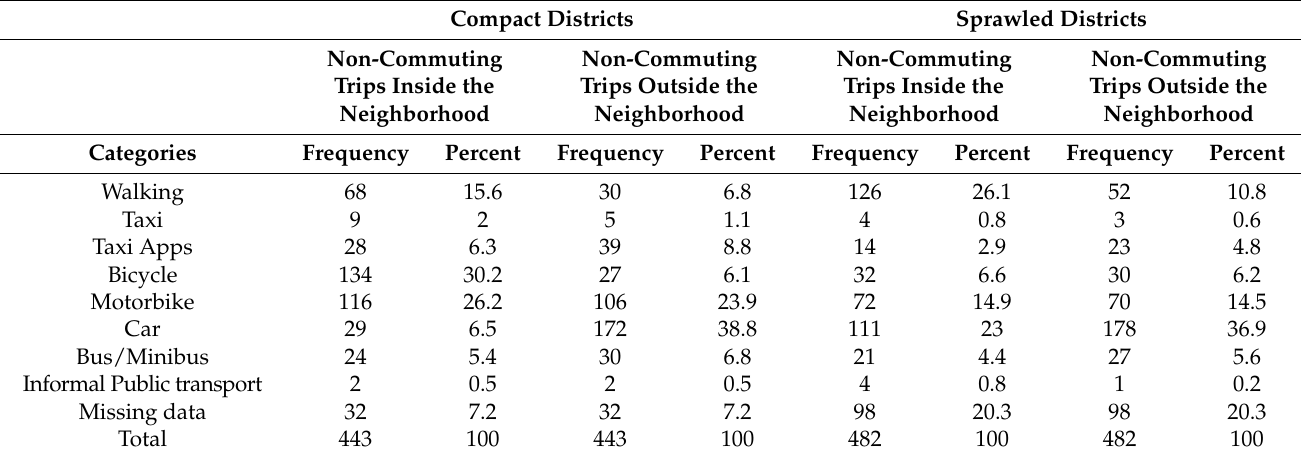
Table 3. Frequency of mode choices in non-commuting trips in two different types of neighborhood.